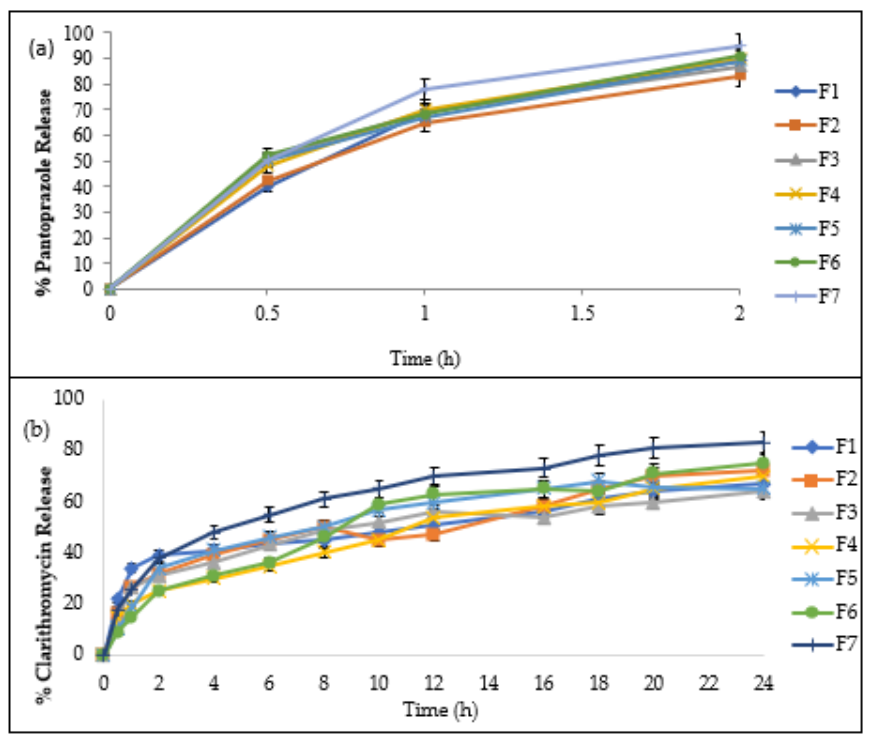
Figure 5. The release profile of ( a ) pantoprazole and ( b ) clarithromycin.